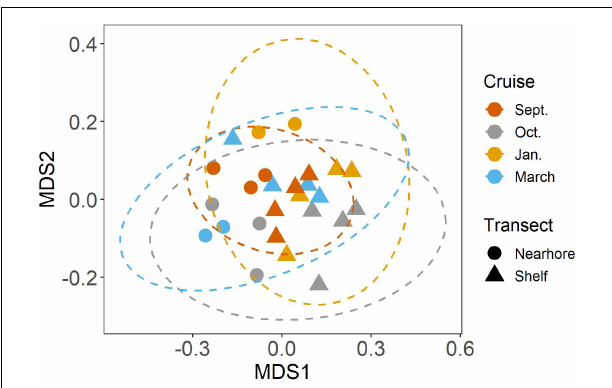
FIGURE 3 | NMDS analysis of mesozooplankton community structure. Colors indicate cruise month. Ellipses represent 95% CI (Solid lines = significant differences in community structure from PERMANOVA, p <